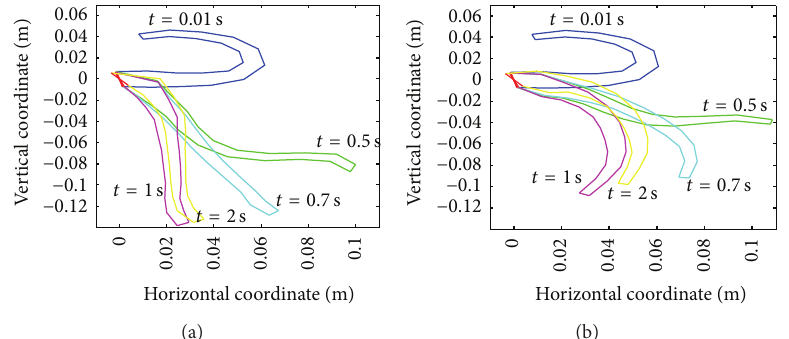
Figure 8: A sequence of octopus arm movements: (a) the third CPG for ventral side and the first CPG for transversal side and (b) the third CPG for dorsal side and the second CPG for transversal